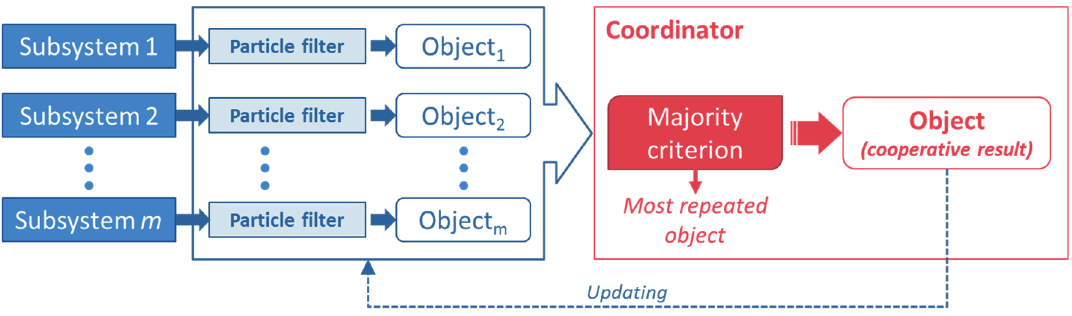
Figure 8. Particle filter implementation made by the coordinator.